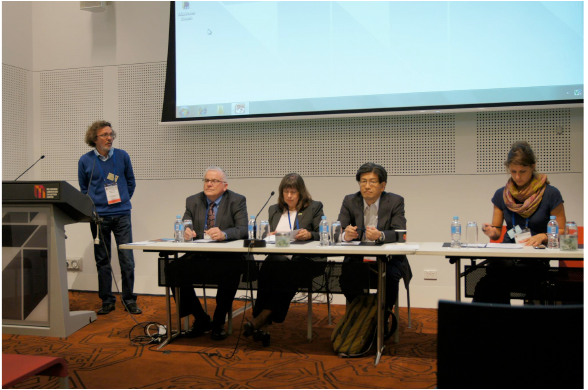
Figure 6. Invited speakers during the panel discussion (ISPRS congress in Melbourne, 2012).